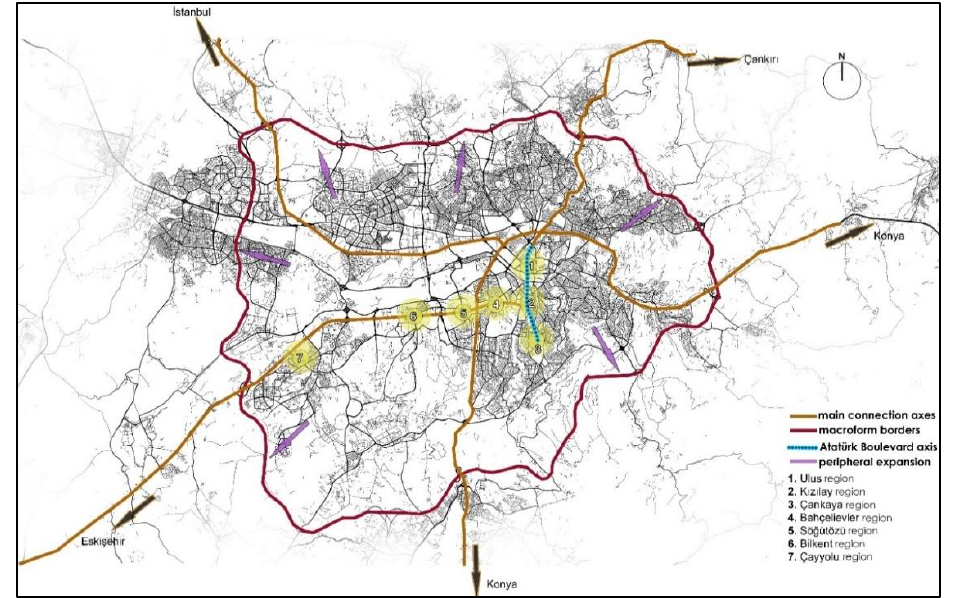
Figure 12 Today Ankara & spatial